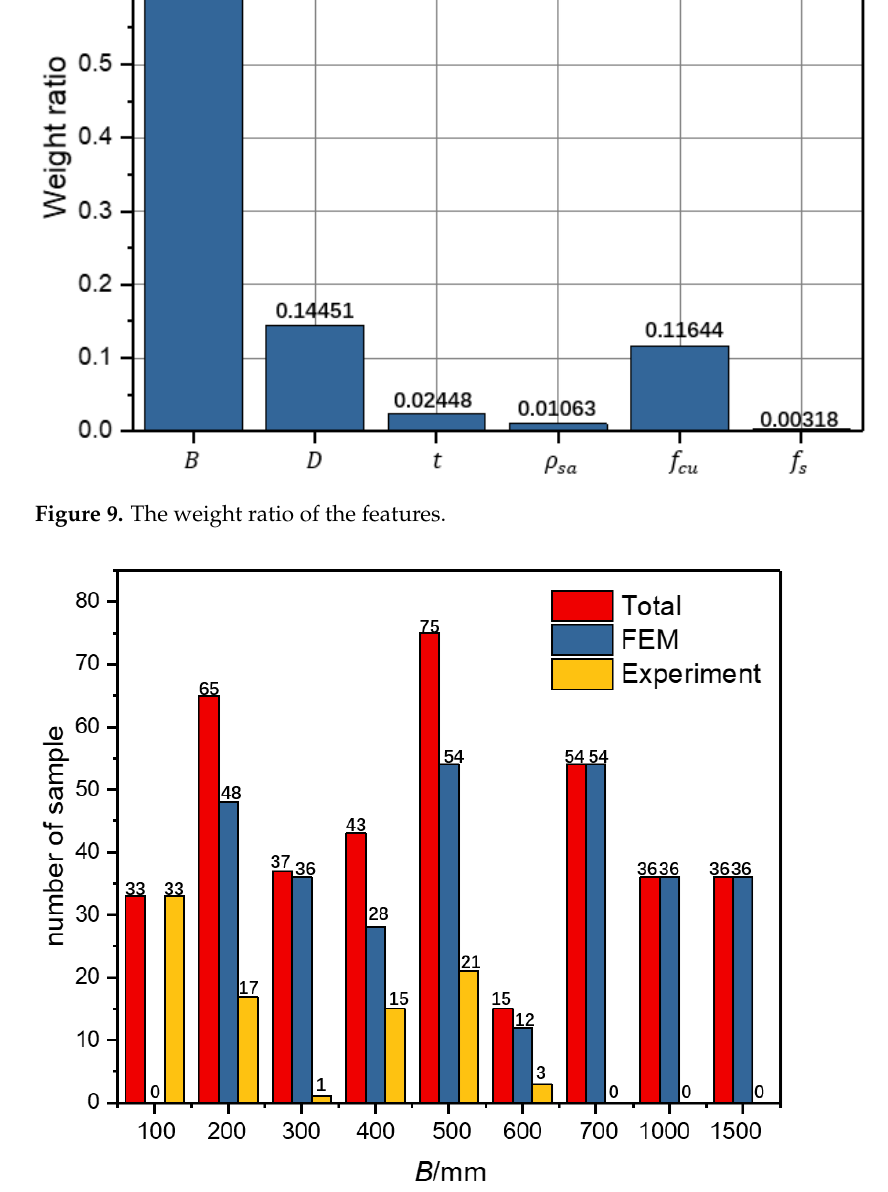
Figure 10. The distribution of 𝐵 of the dataset.